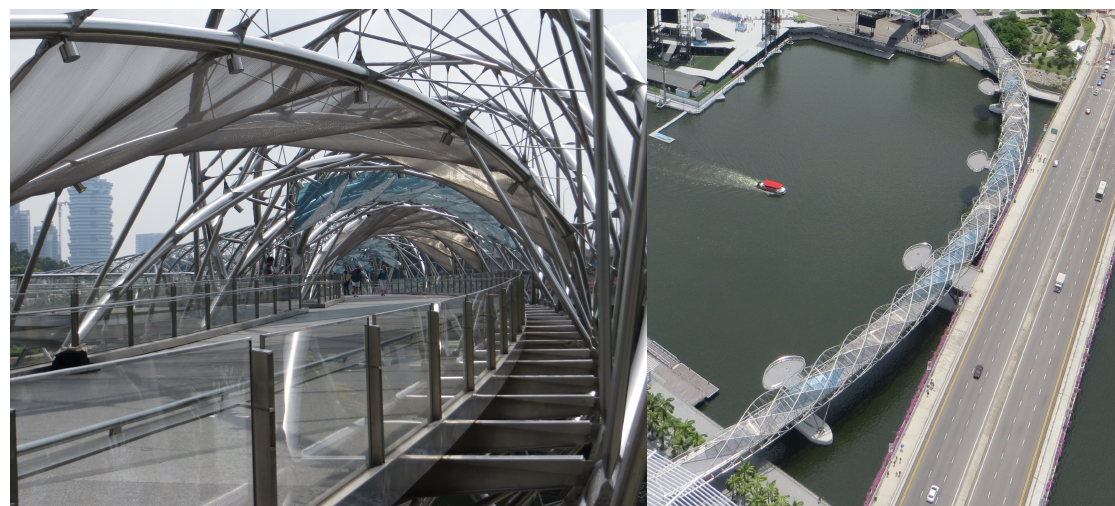
Figure 3. The Helix Bridge is a pedestrian bridge in the Marina Bay area in